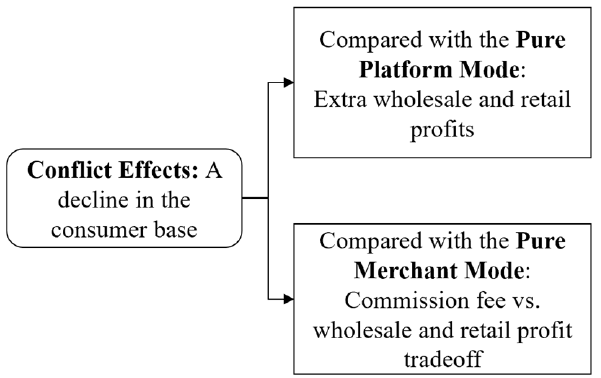
Figure 10. The conflict effects of hybrid mode in the competition case.